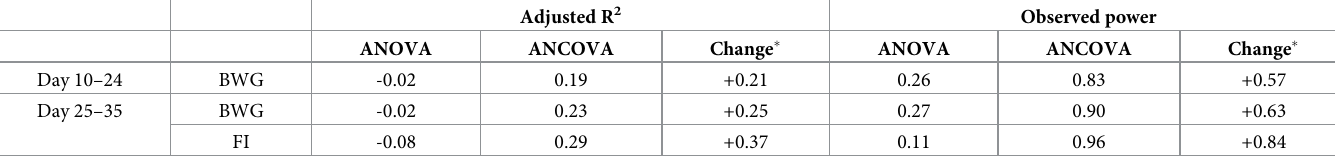
Table 6. Adjusted R 2 and observed power of performance data when analysed by a one-way ANOVA and ANCOVA during different phases for Experiment 2. Adjusted R 2